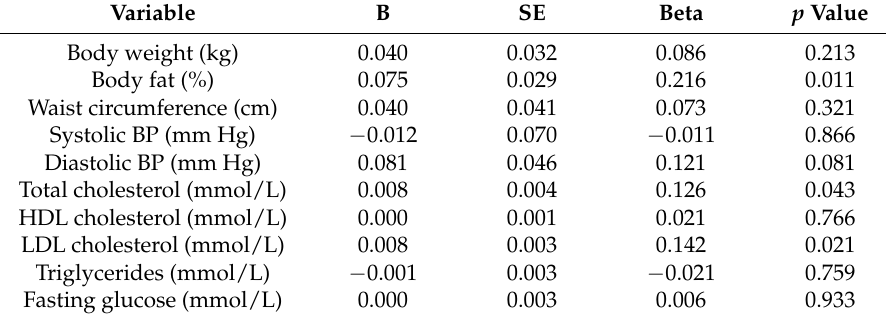
Table 4. Regression coefficients (B), their standard error (SE) and the standardized regression coefficients (Beta) for the associations between changes in anthropometric variables, blood pressure and metabolic factors during the weight maintenance phase and animal protein intake (% of total protein intake) 1